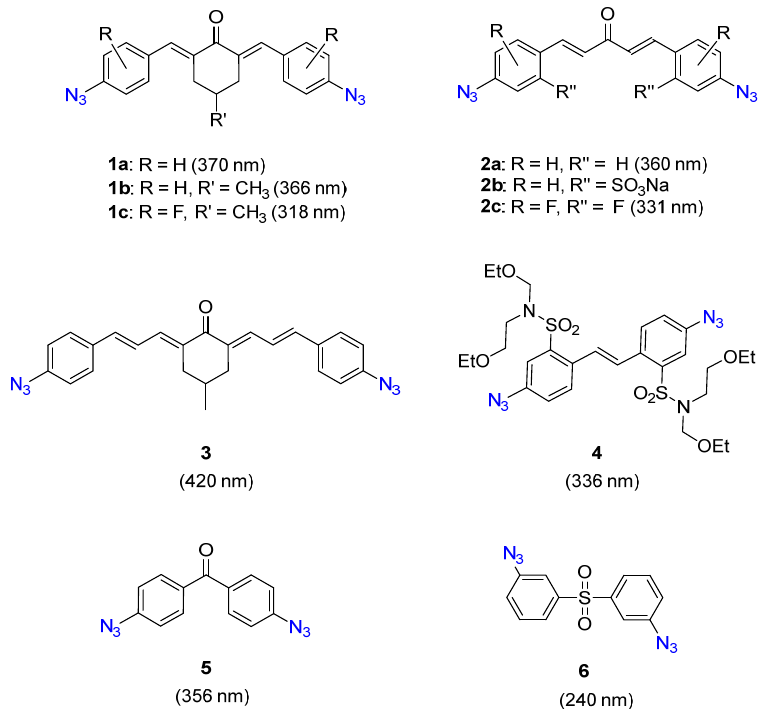
Figure 3. Bisazides used in photoresist systems. Absorption maxima are given in brackets (if available).